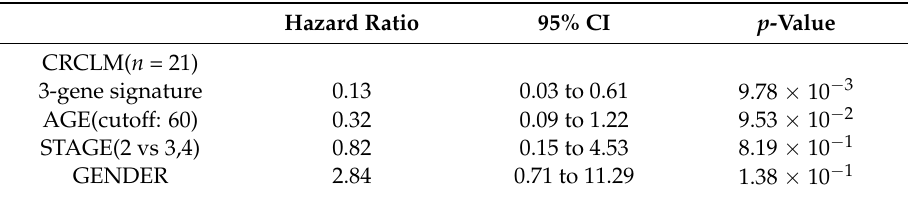
Figure 6. ( A ) Kaplan–Meier relapse-free survival curves of three genes’ copy number variation in 21 CRCLM patients. ( B ) Kaplan–Meier overall survival curves of three genes’ copy number variation in 21 CRCLM patients. ( C ) Kaplan–Meier relapse-free survival curves of three genes’ copy number variation in 45 CRCLM patients. ( D ) Kaplan–Meier overall survival curves of three genes’ copy number variation in 45 CRCLM patients. Table 3. Multivariate Cox regression analysis for 21 CRCLM patients.